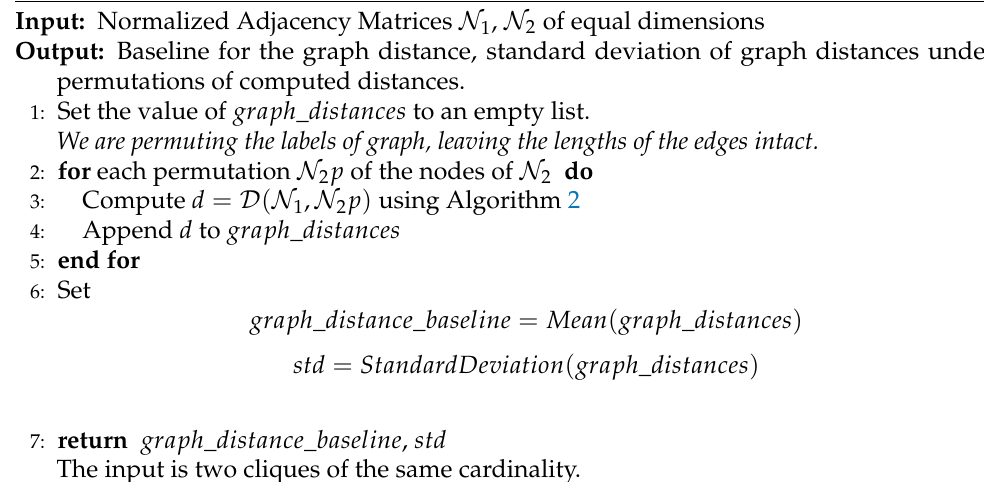
Algorithm 3 Computing Graph Distortion